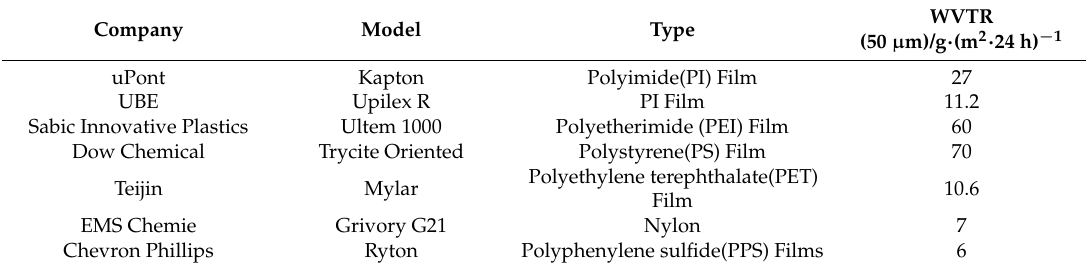
Figure 1. Requirements of products on the barrier performance of barrier materials. OLED: organic light-emitting diode; LCD: liquid-crystal display; WVTR: water vapor transmission rate; OTR: oxygen transmission rate. Table 1. Water vapor permeation of common commercial barrier polymers [37].